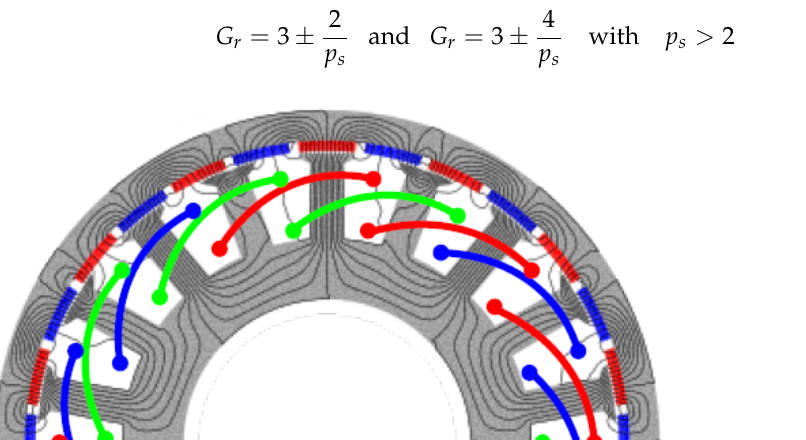
Figure 5. A typical structure of Type-B PMVMs (©[2020] IEEE. Reprinted, with permission from